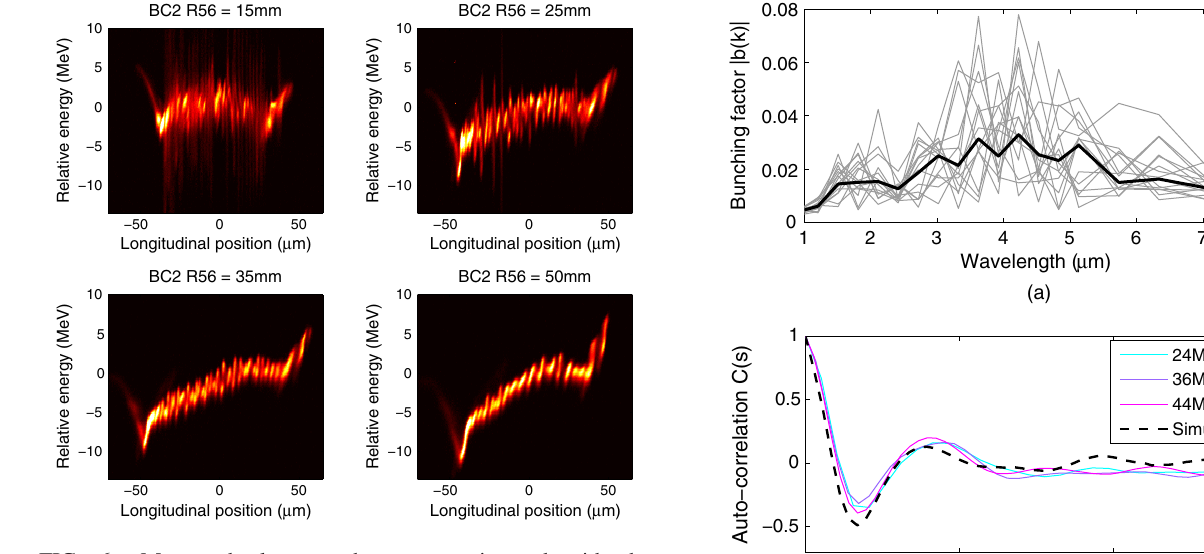
FIG. 6. Measured electron phase space imaged with the XTCAV for different values of BC2 R 56 , but with the same total compression (0.5 kA peak current). All images are with LH off, 44 MV XTCAV voltage, and bunch head to the right.